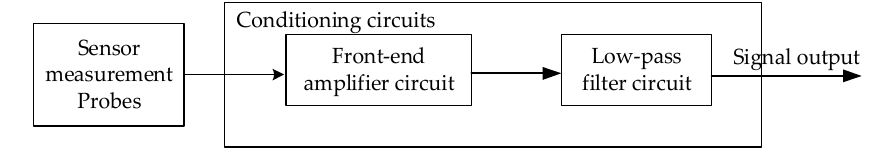
Figure 14. Schematic diagram of electric field sensor conditioning circuit.